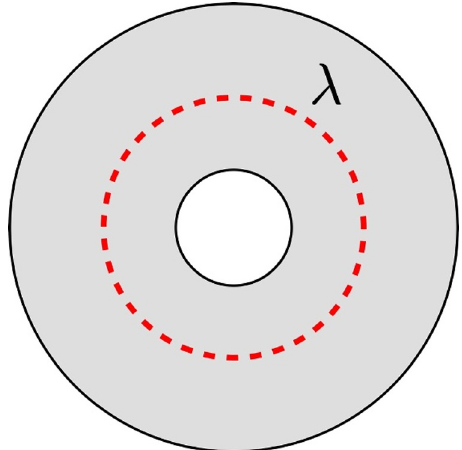
Figure 3 . A topological annulus, with a Wilson loop depicted by a dotted curve. The monodromy is parameterized by (cid:21)